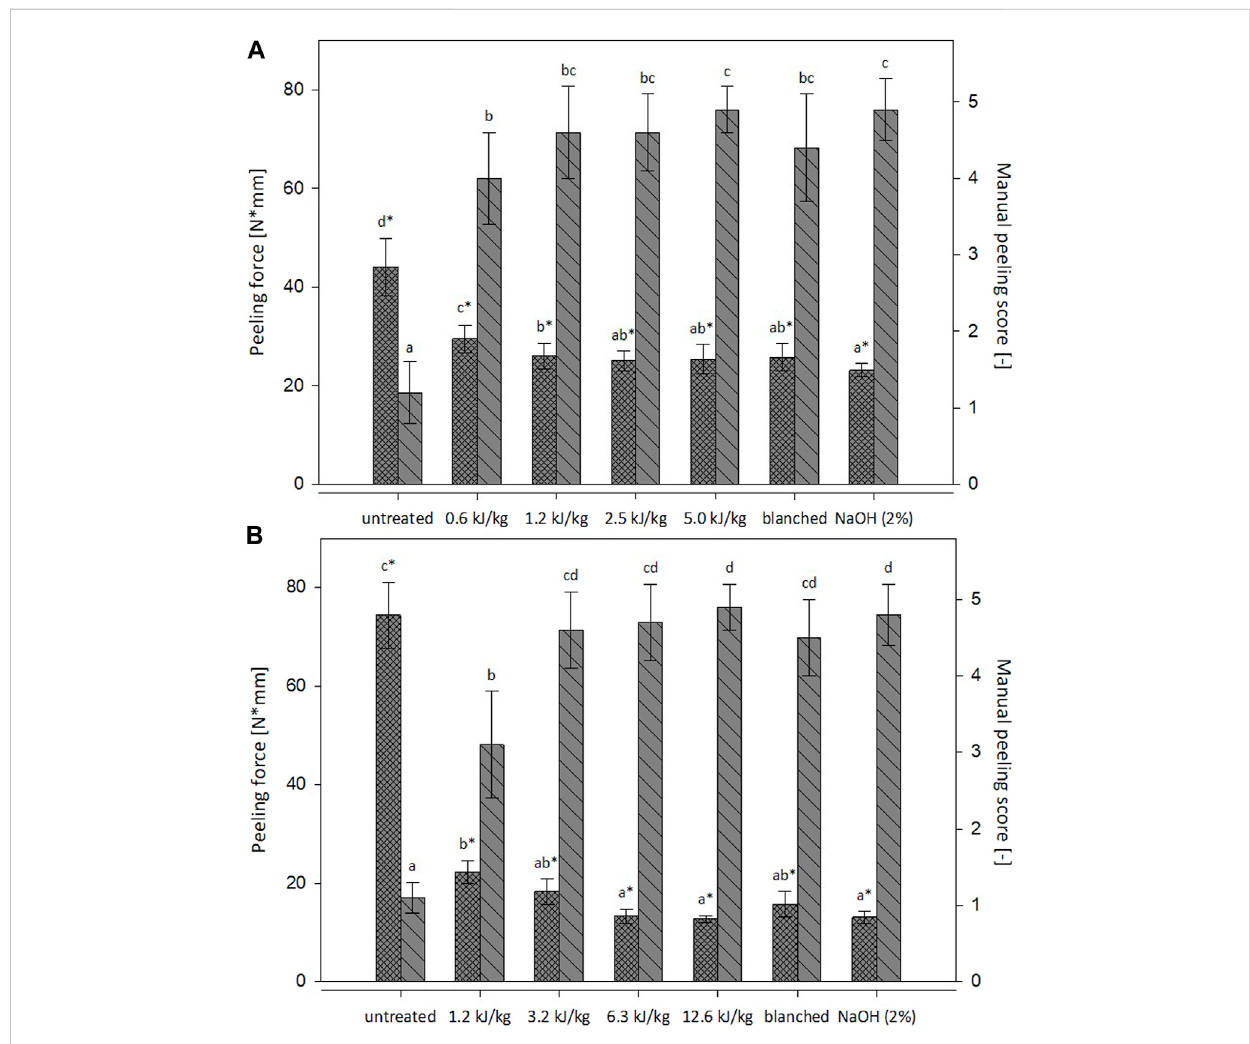
FIGURE 2 Mechanical peeling force (N*mm, ) and manual peeling score (-, ) for untreated, PEF-treated, blanched and lye-peeled tomatoes (A) and kiwi fruits (B) . Signi fi cant differences within the same peeling method (mechanical peeling = a*, manual peeling = a) are indicated by different letters ( p <